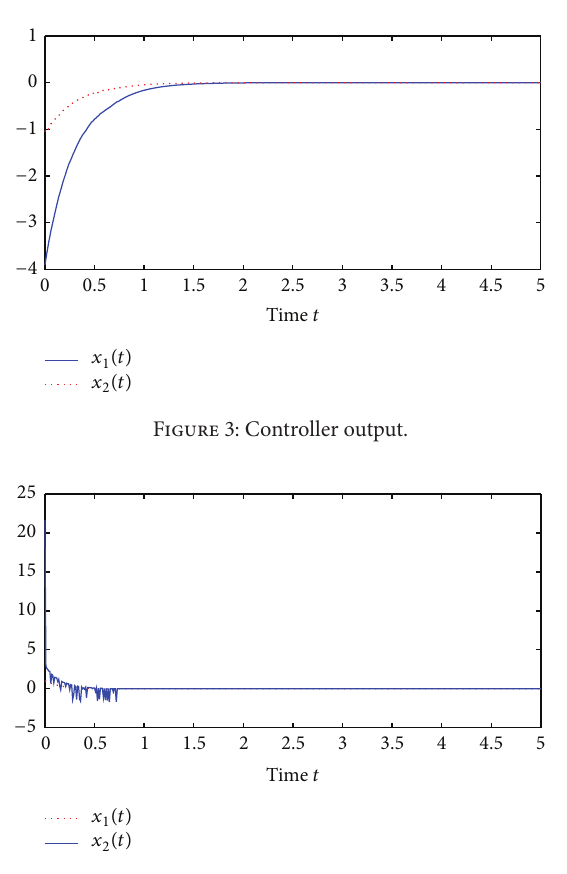
Figure 4: State response of closed-loop system.